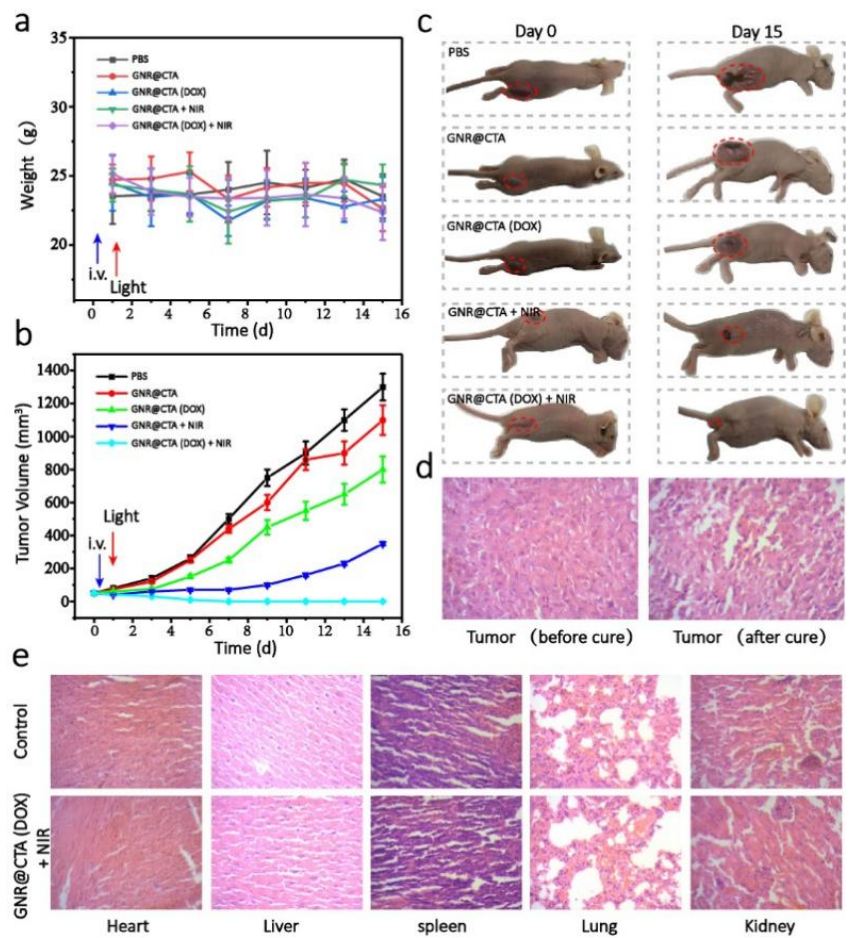
Figure 4. Analysis of anti-tumor therapeutic effect of different materials in nude mice model. ( a ) Nude mice’s weight change curve. ( b ) Changes in tumor size in different groups. ( c ) Comparison of nude mice before and after the experiment, the tumor is marked by the red circle. ( d ) Comparison of tumor tissue sections before and after treatment. ( e ) Compare the tissue sections of the main organs between the experimental group and healthy nude